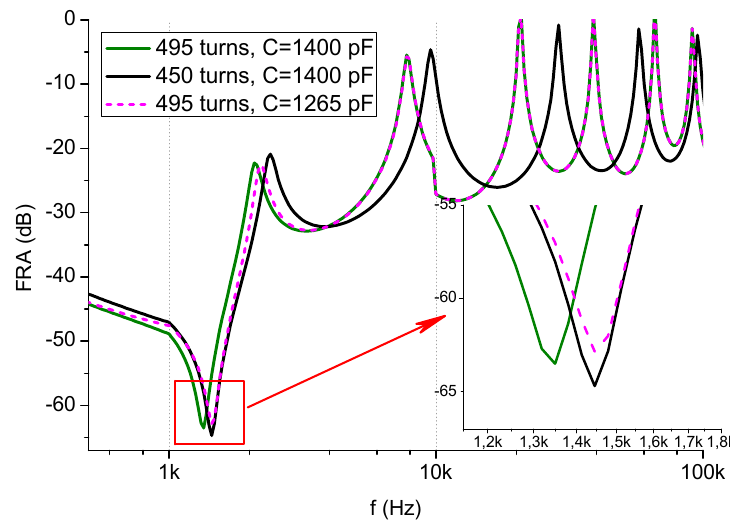
Figure 8. FR modeling for two positions of the tap changer for 405 and 495 turns, and for 495 turns with bushing capacitance change.